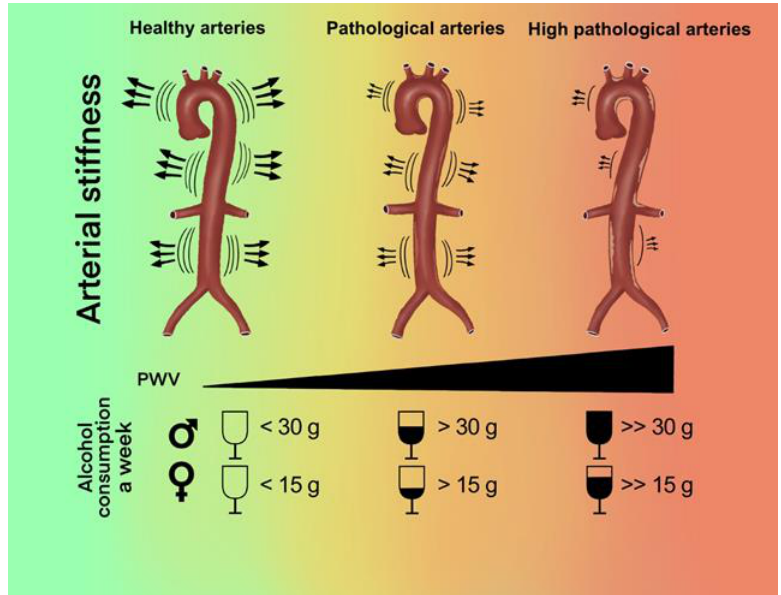
Figure 2. Graphic representation of the results of the systematic review.